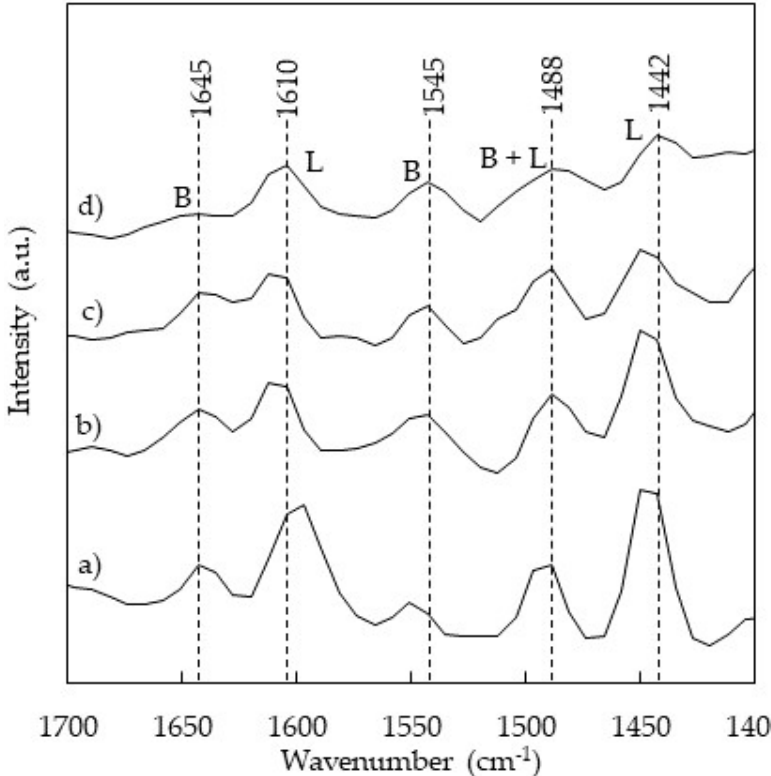
Figure 2. DRIFT spectra of pyridine adsorption on Zr-SBA-15(10) acquired at: ( a ) 100 °C, ( b ) 150 °C, ( c ) 200 °C, ( d ) 300 °C.